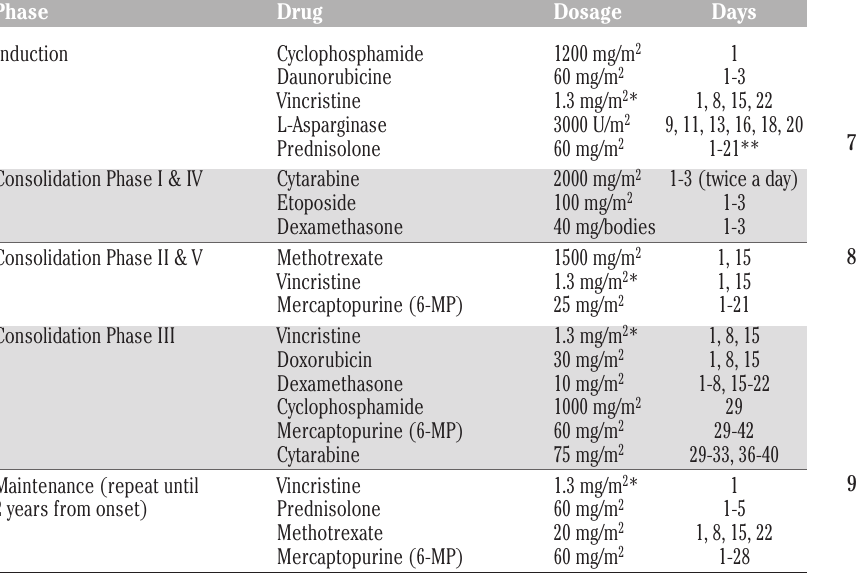
Table 1. JALSG-ALL202 chemotherapy